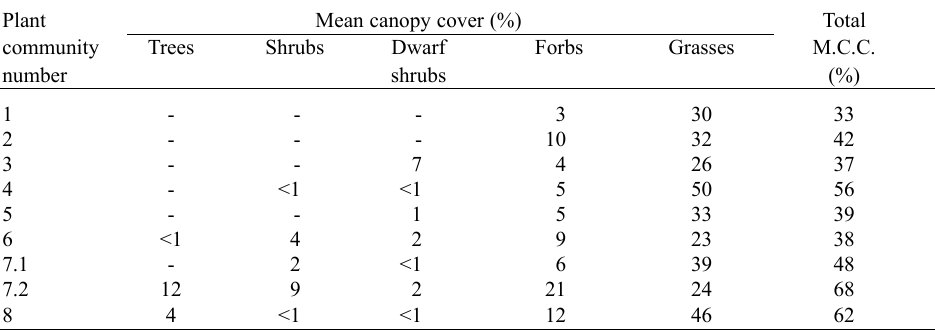
Mean canopy cover (M.C.C) of the plant communities identified in the Grassland Biome section of the Olifants River